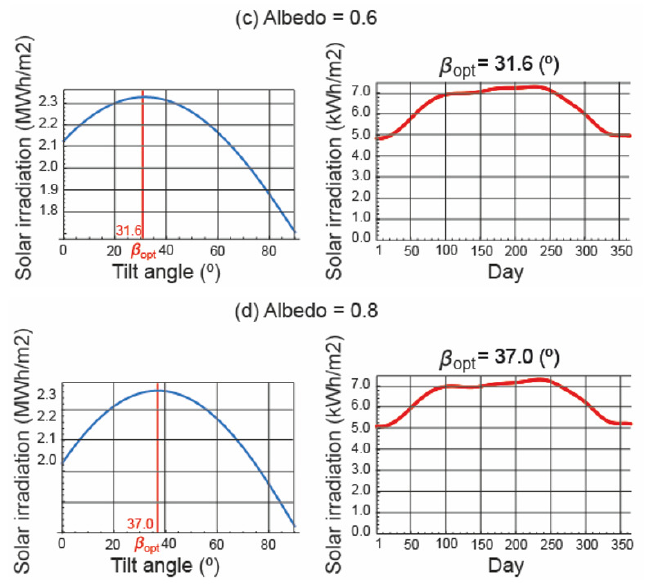
( β ) in Cairo. Figure 6. One discretization for H a t Table 3 shows the maximum annual irradiation for single-axis trackers aligned to the east–west axis for each value of ρ g . These are maximum values which obtain a tilted surface assuming the PV modules are south oriented. Table 3. Maximum annual irradiation (MWh/m 2 ) on a tilted